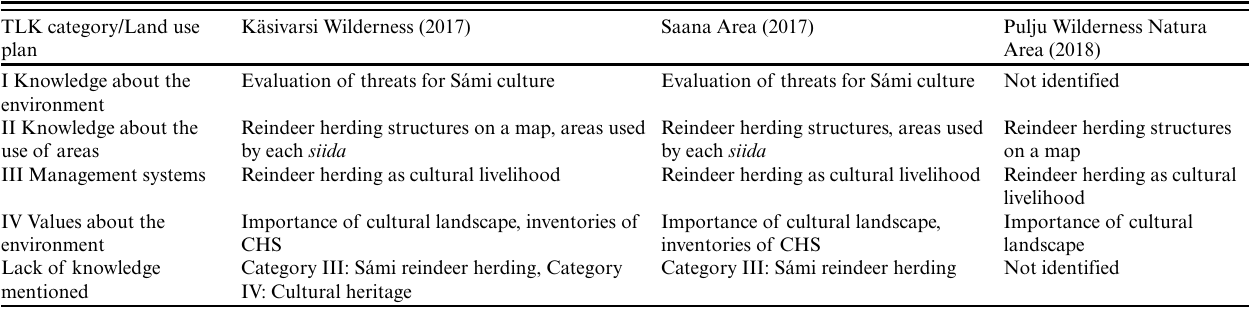
Table 1 . Summary of the evaluation of how different traditional and local knowledge (TLK) categories were taken into account in the land use and management plans of the Käsivarsi Wilderness Area, Saana Area, and Pulju Wilderness Area. The text in each cell describes which data from each TLK category was included and what kind of lack of knowledge was cited in the plans. For a more detailed description of categories, see Material and methods. CHS = Cultural heritage sites. A siida is a traditional Sámi socioeconomic